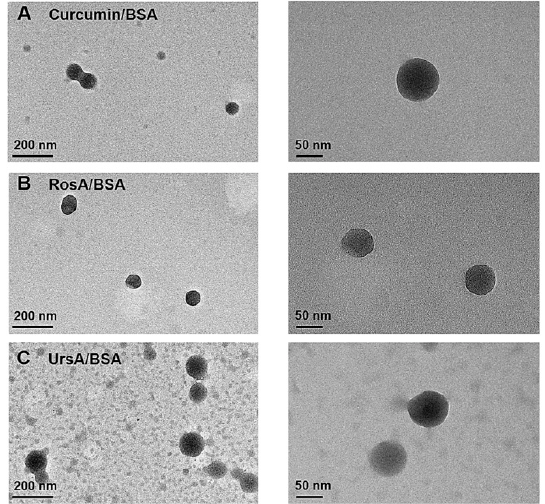
Figure 1. Transmission electron microscopic imaging (TEM) of the drug / BSA nanoparticles. ( A ) curcumin / BSA, ( B ) RosA / BSA, and ( C ) UrsA / BSA. The scale bars are displayed on each